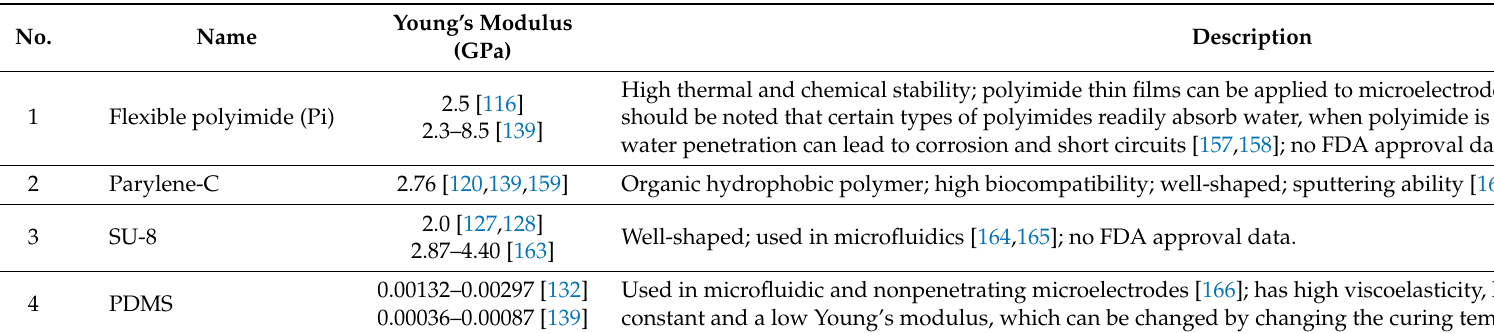
Table 2. Polymer substrates for